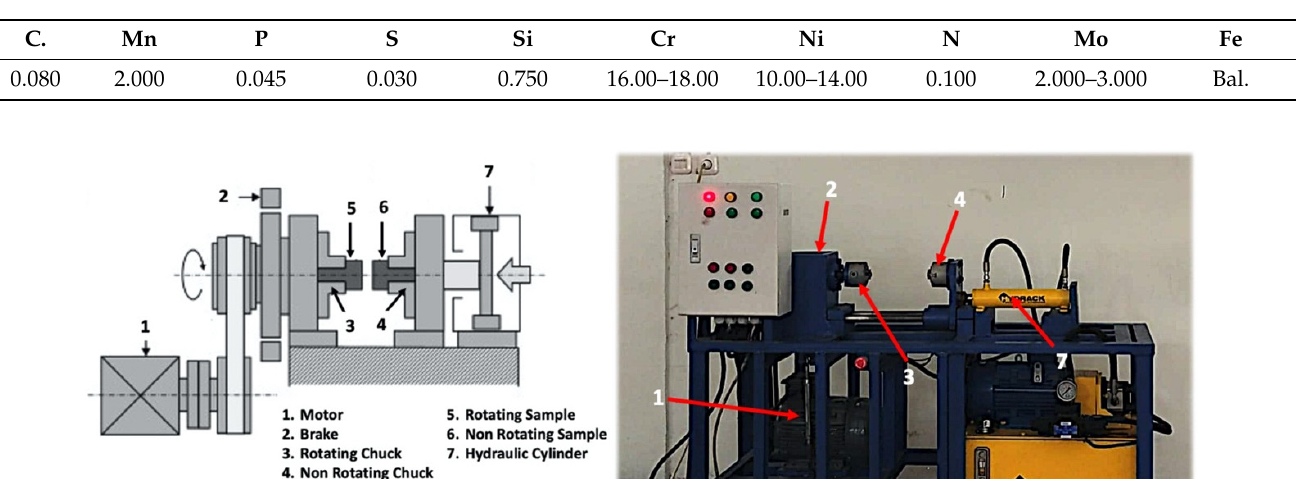
Table 1. Chemical composition of 316 stainless steel (wt.%).